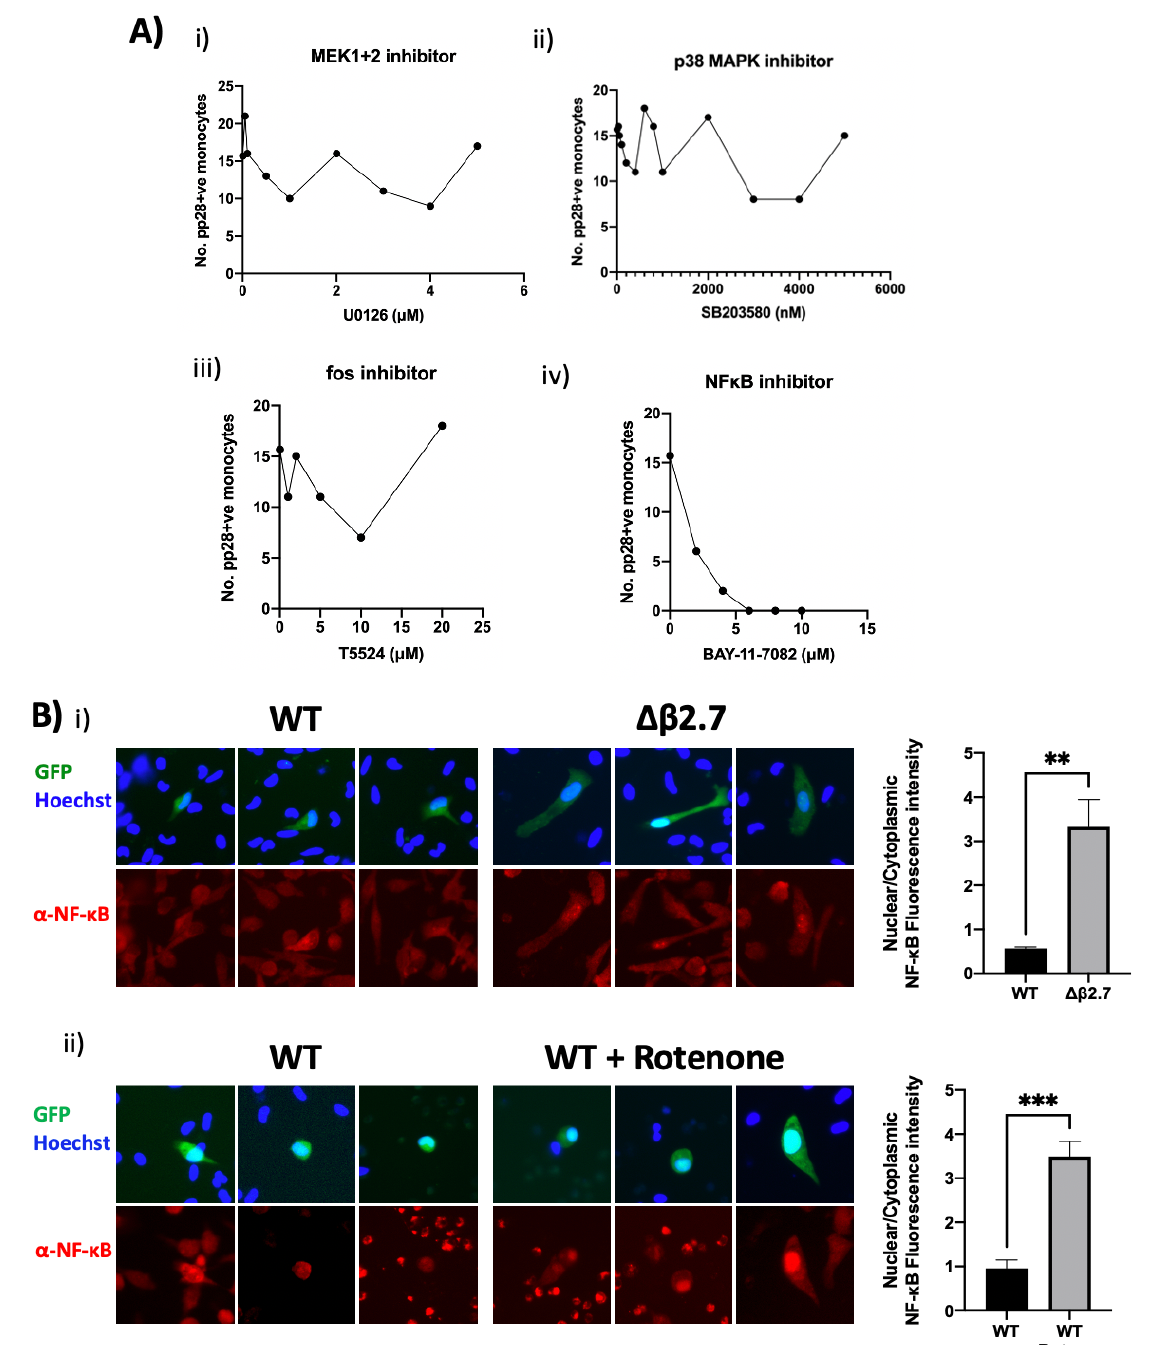
Figure 11. NF- κ B activation is essential for ROS-mediated reactivation. ( A ) CD14+ monocytes were infected with ∆ β 2.7 TB40E SV40-GFP ( ∆ β 2.7) virus at an MOI of 5. At 3 h.p.i, cells were treated with the indicated concentrations of (i) U0126 (MEK1/MEK2 inhibitor), (ii) SB203580 (p38 MAPK inhibitor), (iii) T5524 (fos inhibitor) or (iv) BAY-11-7082 (NF- κ B inhibitor). At 7 d.p.i, cells were fixed, stained for pp28, and the number of pp28+ monocytes enumerated. ( B ) CD14+ monocytes were infected with WT TB40E SV40-GFP (WT) or ∆ β 2.7 TB40E SV40-GFP ( ∆ β 2.7). (i) At 3 d.p.i cells were fixed and stained for NF- κ B and imaged under the fluorescence microscope. (ii) As in ( B (i)), but with rotenone treatment at 4 d.p.i and fixation at 7 d.p.i. Fluorescence intensity was quantified using densitometry analysis in ImageJ and is presented as a ratio of nuclear: cytoplasmic brightness. ** = p < 0.01, *** = p <